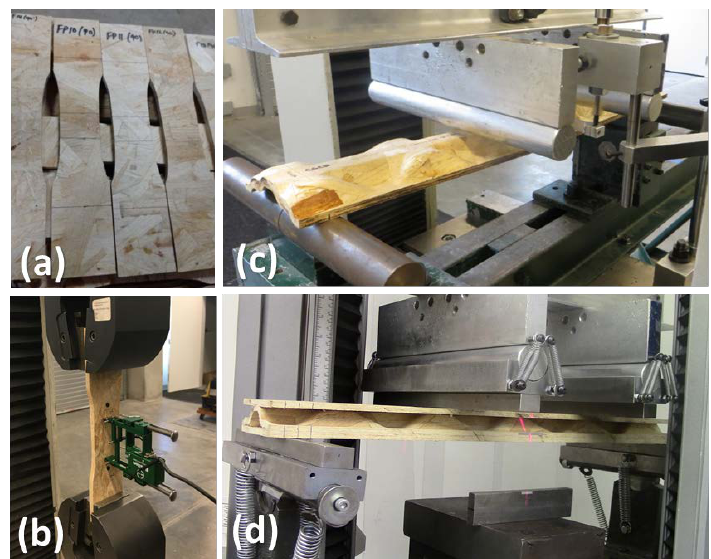
Figure 3. Mechanical testing: ( a ) tension specimens, ( b ) tensile testing, ( c ) bending of corrugated core, and ( d ) bending of sandwich beam.